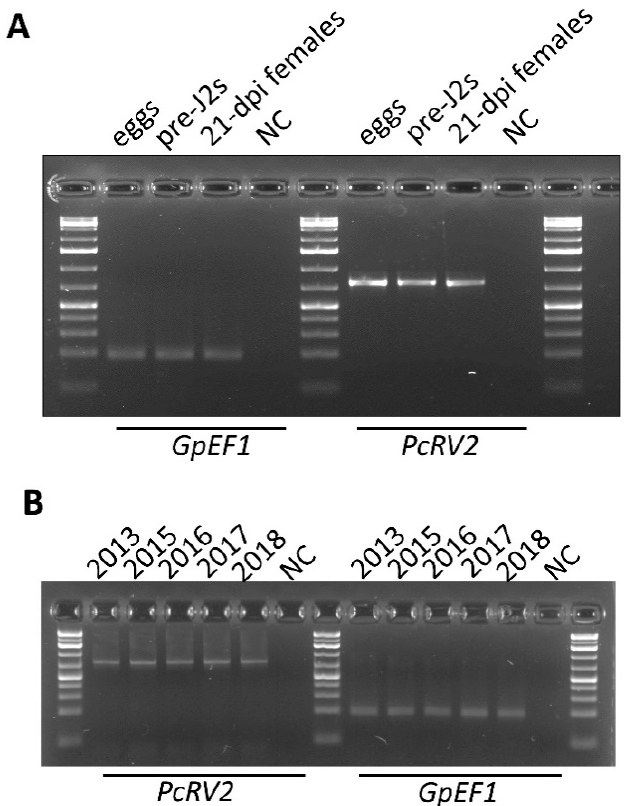
Figure 4. Detection of potato cyst nematode rhabdovirus (PcRV) across different life stages of G. pallida ( A ) and its prevalence in the inbred G. pallida populations (reared in 2013, 2015, 2016, 2017, and 2018) ( B ). Globodera EF1 gene was used as a positive control. NC—negative non-template control. Pre-J2s—invasive juveniles. dpi—days post infection.